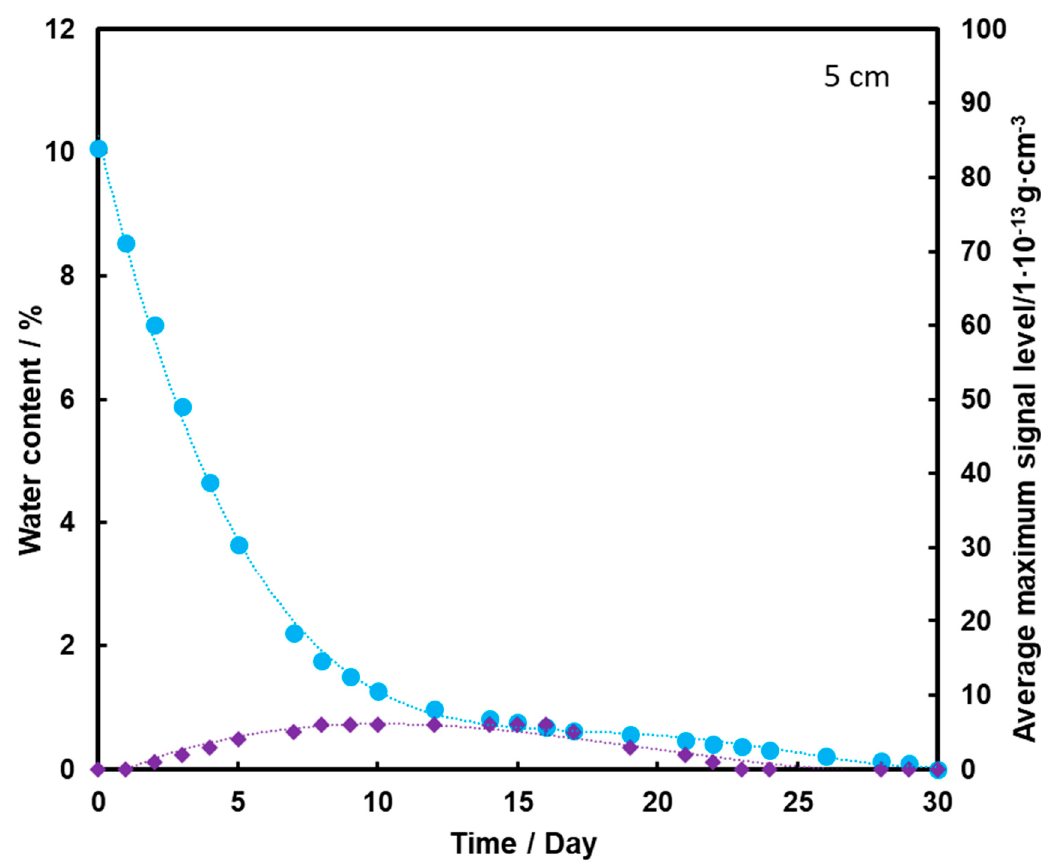
Figure 7. Dependence of the mean maximum TNT signal ( ♦ ) on the amount of water ( ● ) in the substrate for the TNT sample at a depth of 5 cm, at a temperature of 25 °C.